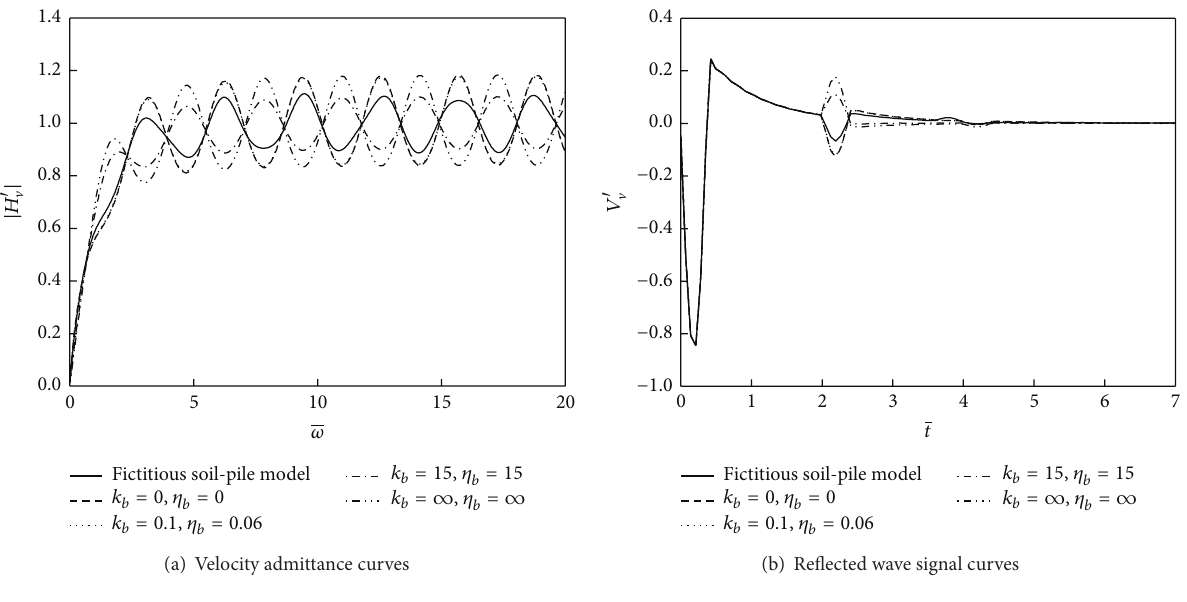
Figure 8: Comparison of the fictitious soil-pile model with other support